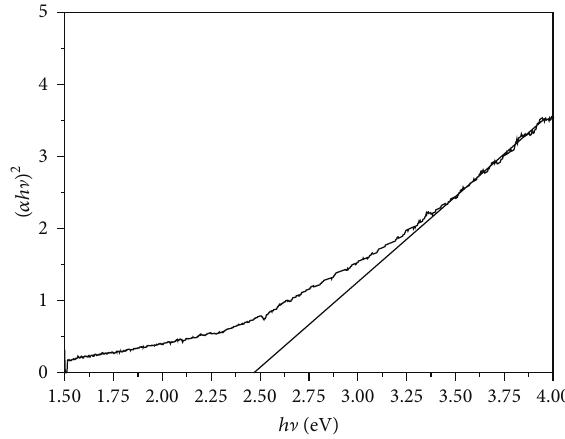
Figure 7: Plot of (𝛼ℎ ] ) 2 versus ℎ ] for ZrO 2 sample calcinated at 400 ∘ C.